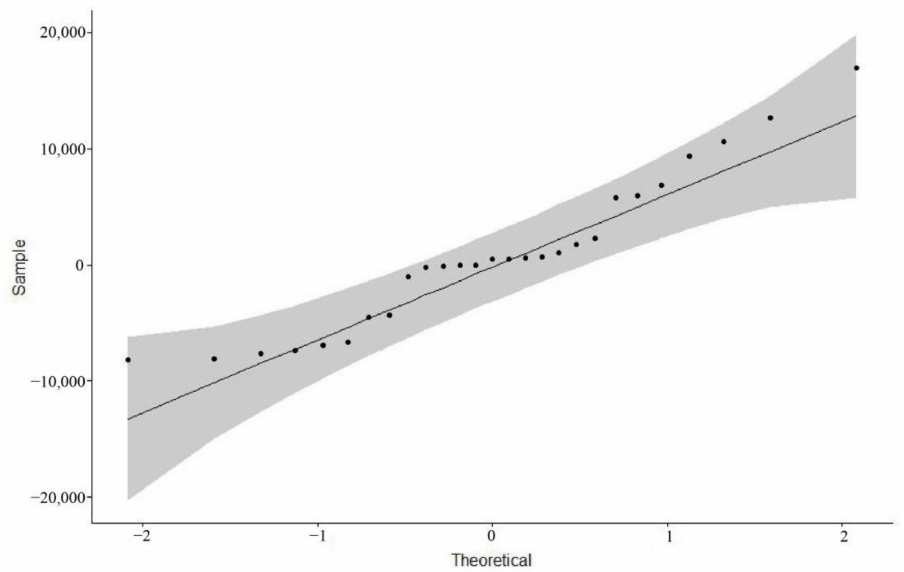
Figure 7. The normal distribution QQ plot of the residuals of the ARIMA ( 0 , 2 , 2 )